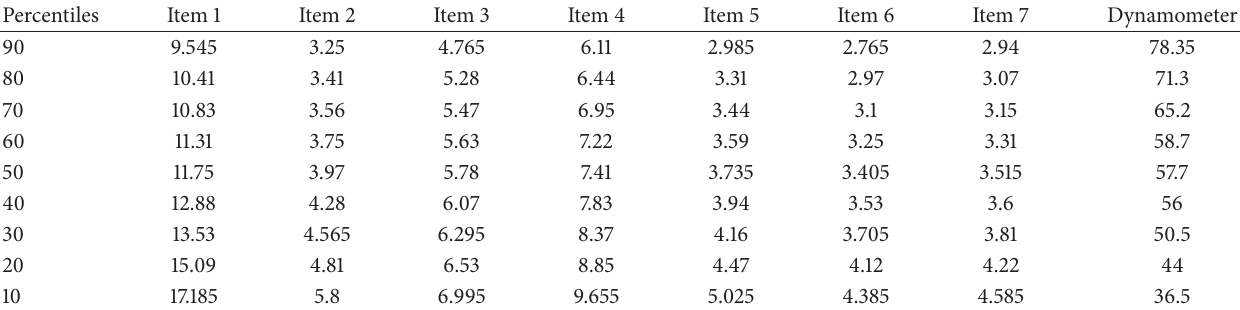
Table 20: 𝑛 = 74 , females, 20–94, dominant hand, educational instruction: secondary school.